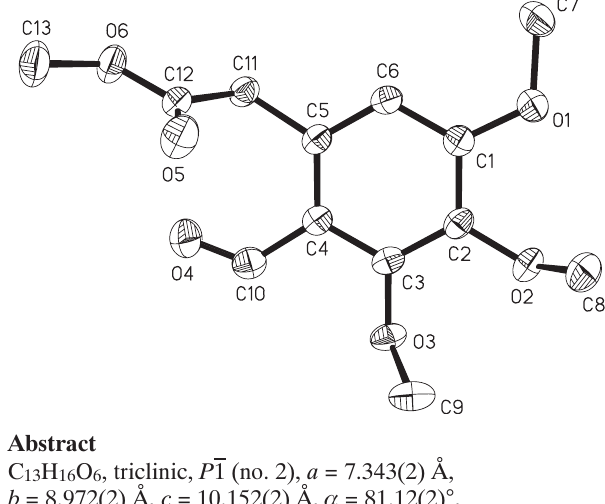
Table 1. Data collection and handling.